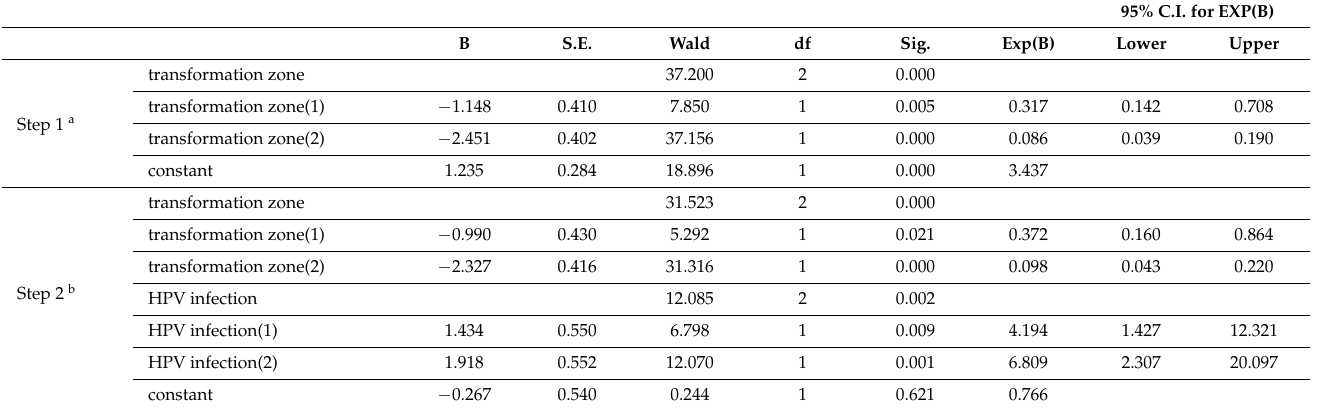
Table 4. Selection